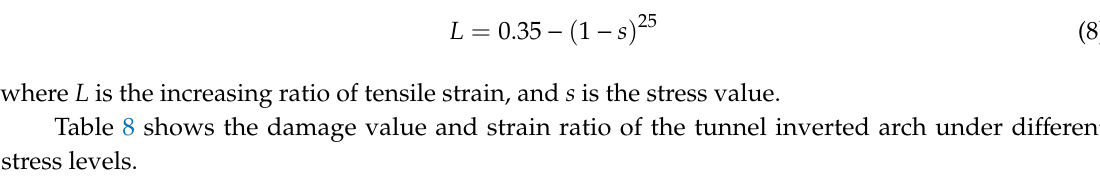
Table 8. Damage value and strain ratio of the inverted arch under di ff erent stress levels.